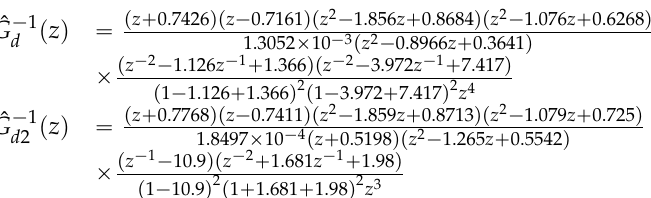
( b ) Figure 23. Frequency characteristics of identified models and designed inverse models. ( a ) Magnitude frequency characteristics; ( b ) Phase frequency characteristics. Note that the G d and G d 2 in Equation (43) seem to be noticeably different even though the tables are supposed to be synchronized. The noticeable difference in Equation (43) is mainly due to the fact that the order of the identified model is relatively high and there is some difference when the frequency is relatively high, as shown in Figure 23. Especially, the difference of the phase characteristic of the two tables is noticeable. However, the G d and G d 2 have the similar characteristics when the frequency is not too high both in magnitude and phase characteristics, as shown in Figure 23 and we are concerned within the characteristics within the medium and low frequency range. So, the obtained results for G d and G d 2 in Equation (43) are correct and reasonable. To verify the proposed tracking controller shown in Figure 12, the 1.5 mm 20 Hz sine signals are given and the test results are shown in Figure 24. Note that the tracking control tests below are both with the proposed ASMC synchronization controller. Also, the frequency parameter f q in Equation (37) is 48 Hz during the experimental tests. It can be seen in Figure 24a that the maximum tracking